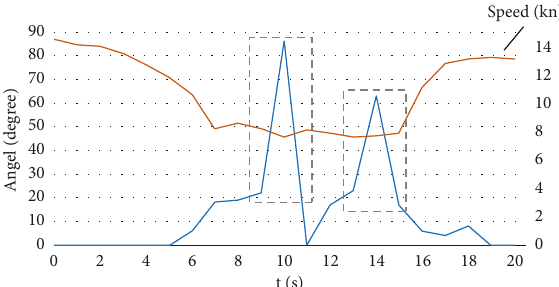
Figure 4: Anomaly detection results of ship